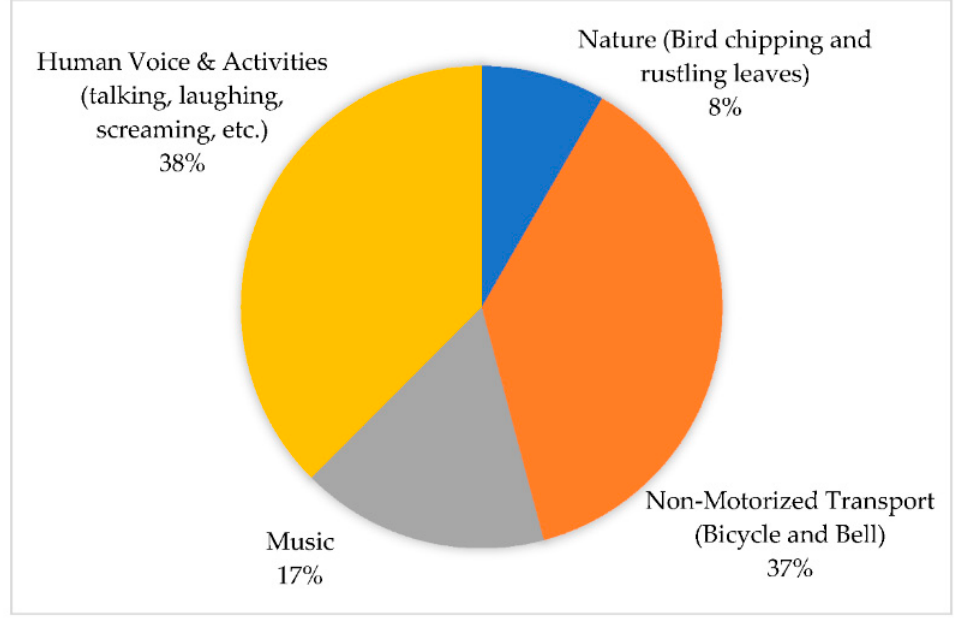
Figure 22. The classification of identified sound sources on Weekdays.